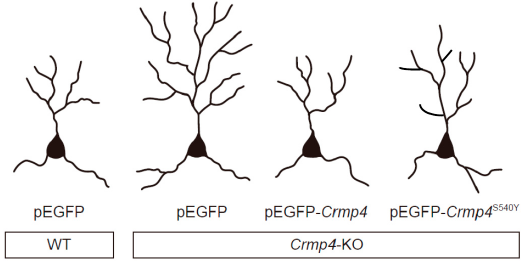
Figure 1. Schematic drawings showing dendritic arborization of cultured hippocampal pyramidal neurons differentially expressing CRMP4. The S540Y mutation in mouse Crmp4 is homologous to S541Y in human CRMP4 , which was observed in a patient with autism spectrum disorder (ASD). Representative drawings of cultured hippocampal cells from wildtype (WT) mice transfected with control (pEGFP) vector, Crmp4 -knockout (KO) mice transfected with pEGFP vector, Crmp4 -KO mice transfected with pEGFP- Crmp4 vector, and Crmp4 -KO mice transfected with pEGFP- Crmp4 S540Y vector. CRMP: collapsin response mediator protein.